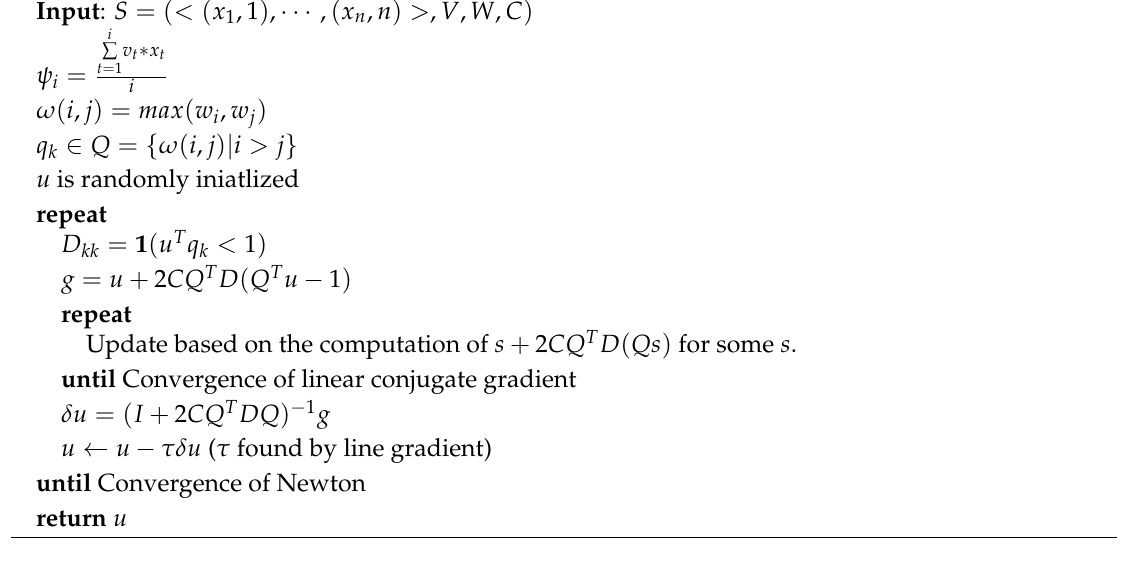
Algorithm 1 The solution of Equation (3). The Newton step is computed with linear conjugate